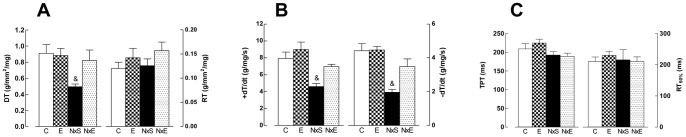
Papillary Muscle.Sedentary control (C), exercise control (E), sedentary 5/6Nx (NxS), exercise 5/6Nx (NxE). 
Figure 3

 A - developed tension (DT), resting tension (RT) expressed in g/mm2/mg, 
Figure 3

 B - maximum rate of tension development (+dT/dt) and tension decline (–dT/dt) derivative expressed in g/mg/s and 
Figure 3

 C - time to peak tension (TPT) and time from peak tension to 50% relaxation (RT50%) expressed in ms. & p<0.05 vs. all groups.